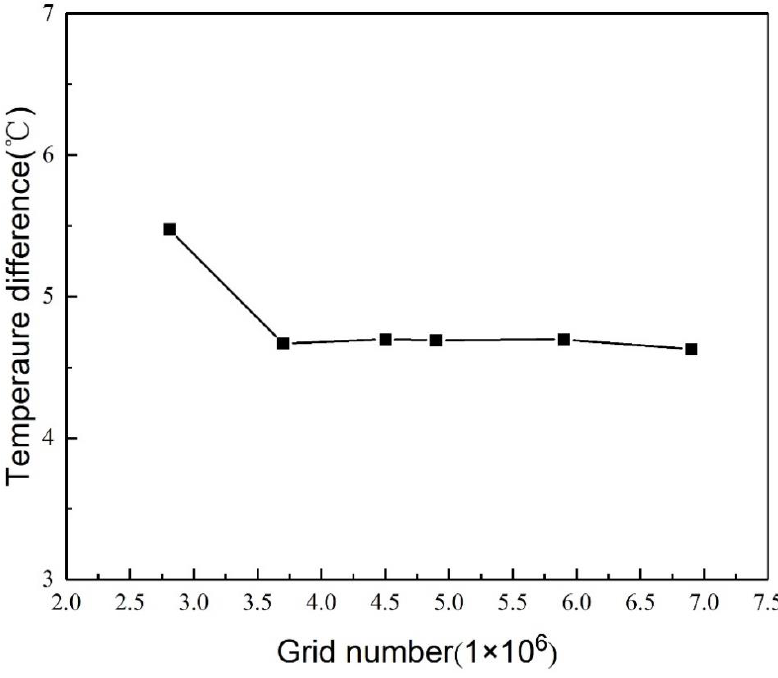
Figure 3. Mesh number independence test.